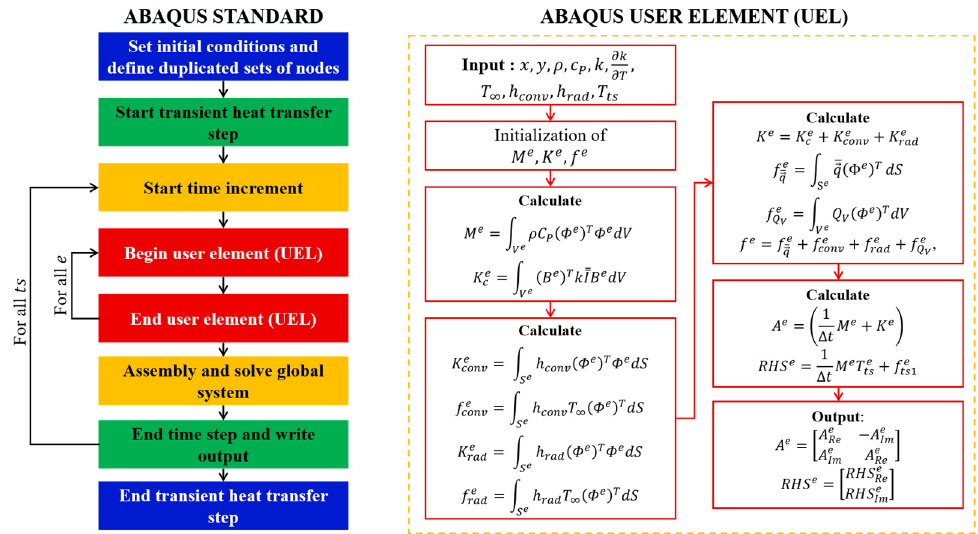
Figure 3. Flowchart of Transient Thermal ZFEM and Abaqus User Element Subroutine. All complex operations are performed inside the UEL and the A matrix and the RHS vector are decomposed into Cauchy-Riemann form before exiting the UEL.